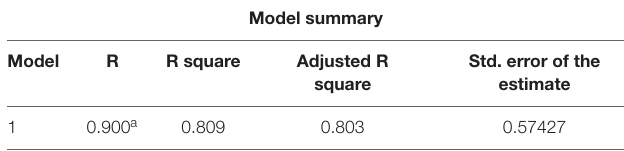
TABLE 9 | Multiple regression analysis for private institute learners.